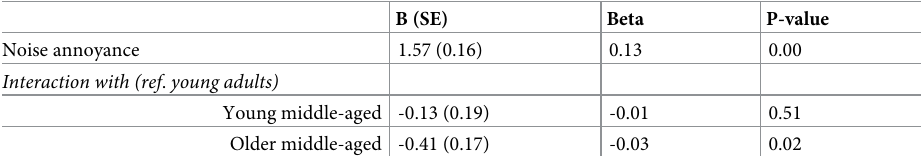
Table 4. Interaction effects of noise annoyance for different age